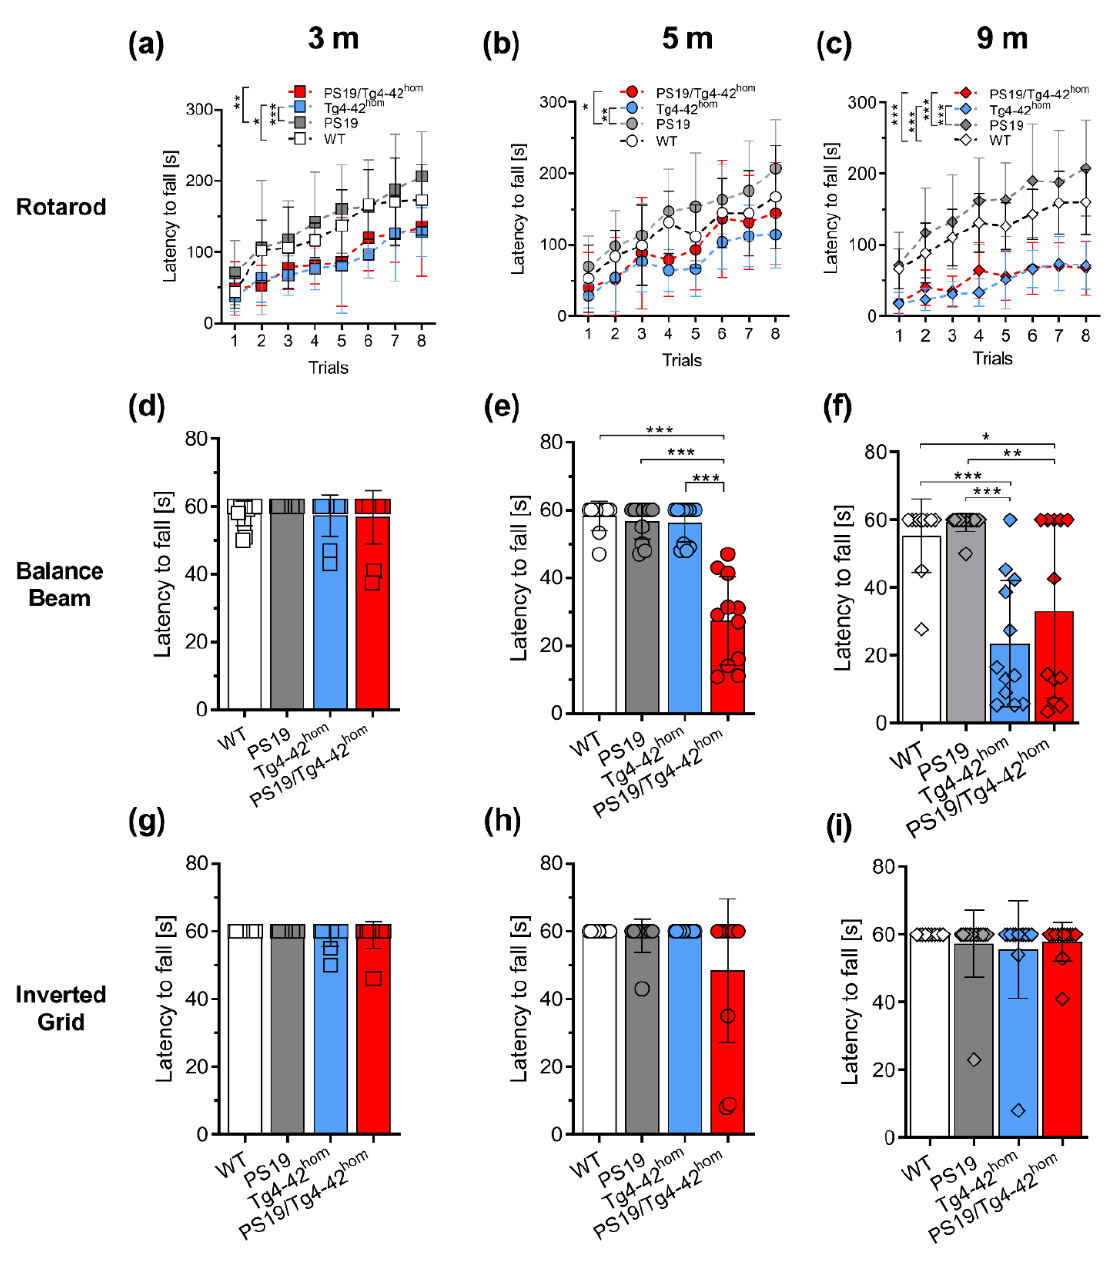
Figure 2. Partial worsening of motor performances in 5-month-old PS19/Tg4–42 hom mice. Female and male WT, PS19, Tg4–42 hom and PS19/Tg4–42 hom mice were tested in the accelerating rotarod ( a – c ), balance beam ( d–f ) and inverted grid ( g–i ) tasks at 3, 5 and 9 months of age (n = 12–14). Motor deficits in the accelerating rotarod task were observed in both Tg4–42 hom and PS19/Tg4–42 hom mice ( a–c ), while only the bigenic line showed a significant reduced latency to fall from the balance beam at 5 months ( e ). At 9 months, both Tg4–42 hom and PS19/Tg4–42 hom mice revealed a deficit ( f ). No significant differences were observed in the inverted grid task at any age ( g – i ). All data are given as mean ± SD. ( a – c ) Two-way ANOVA RM, followed by Bonferroni’s multiple comparison, ( d – i ) One-way ANOVA, followed by Bonferroni’s multiple comparison: * p < 0.05, ** p < 0.01, *** p <